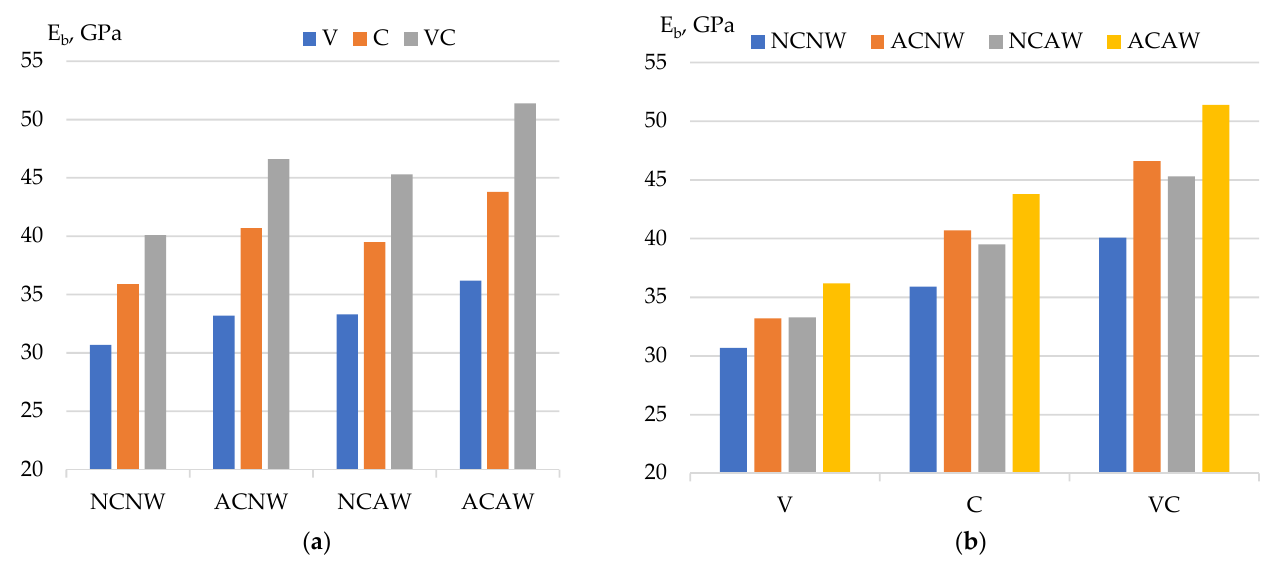
Figure 11. Dependence of the modulus of elasticity in compression of concrete: ( a ) on the type of activation, ( b ) on the type of technology for its manufacture.